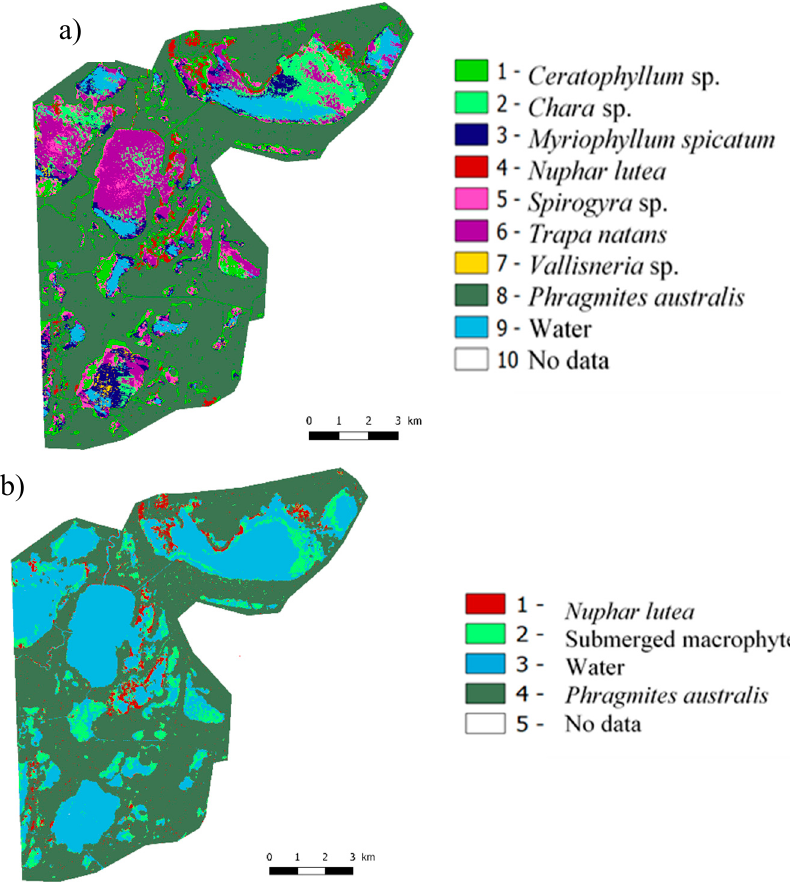
Figure 9. Macrophyte classifications for the north zone. ( a ) Classification of the S2 stack (bands and indices; 07 / 17 / 2016) with S1, in detailed nomenclature. ( b ) Classification of the Pleiades stack (bands and indices; 07 / 11 / 2017) with S1 in simple nomenclature.